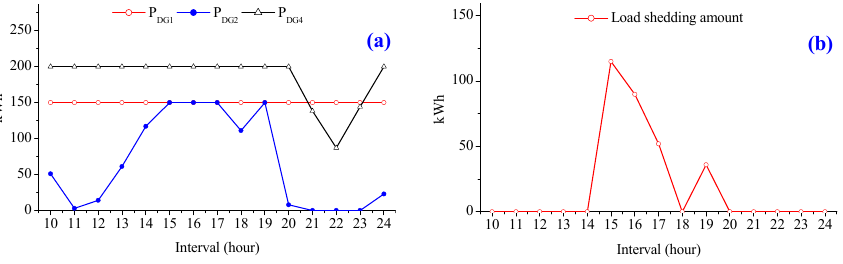
Figure 12. Operation results of power failure part for remaining intervals (rescheduling by MG-EMS): ( a ) output power of DG units; and ( b ) load shedding amount.